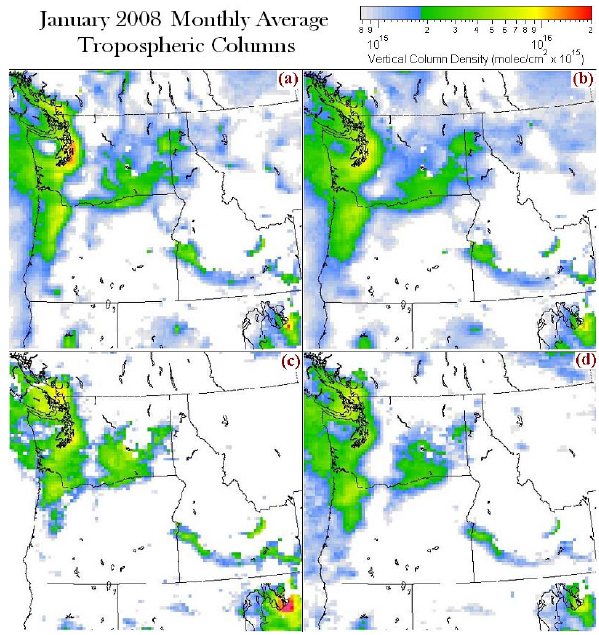
Fig. 5. Average tropospheric NO 2 columns are shown for the month of January, 2008: AIRPACT (a) at upper left, spatially averaged AIRPACT (b) at upper right, KNMI OMI (c) at lower left, and NASA OMI (d) at lower right. The pink color denotes values over 2 × 10 16 molecules per square